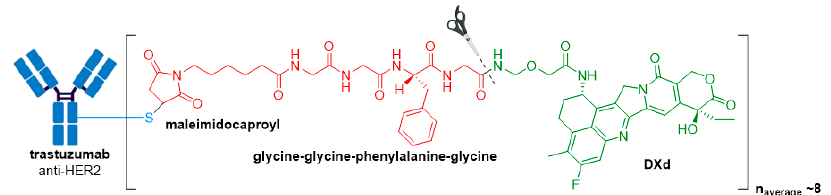
Figure 11. Structure of Enhertu ® (fam-trastuzumab deruxtecan-nxki). The antibody is shown in blue, and chemical structures for linker and payload are in red and green, respectively.